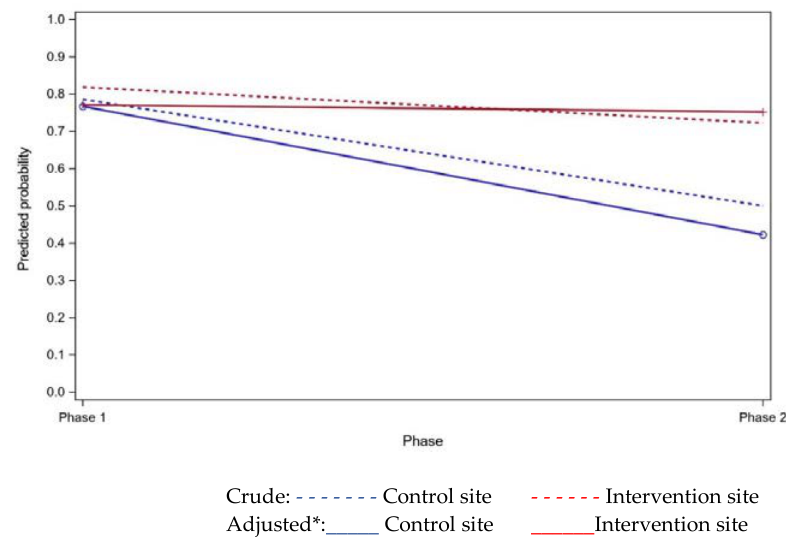
Figure 2. Predicted probability of dose administration aid (DAA) use (three months after discharge) from regression modelling. *Adjusted for carer gender, age, and relationship.